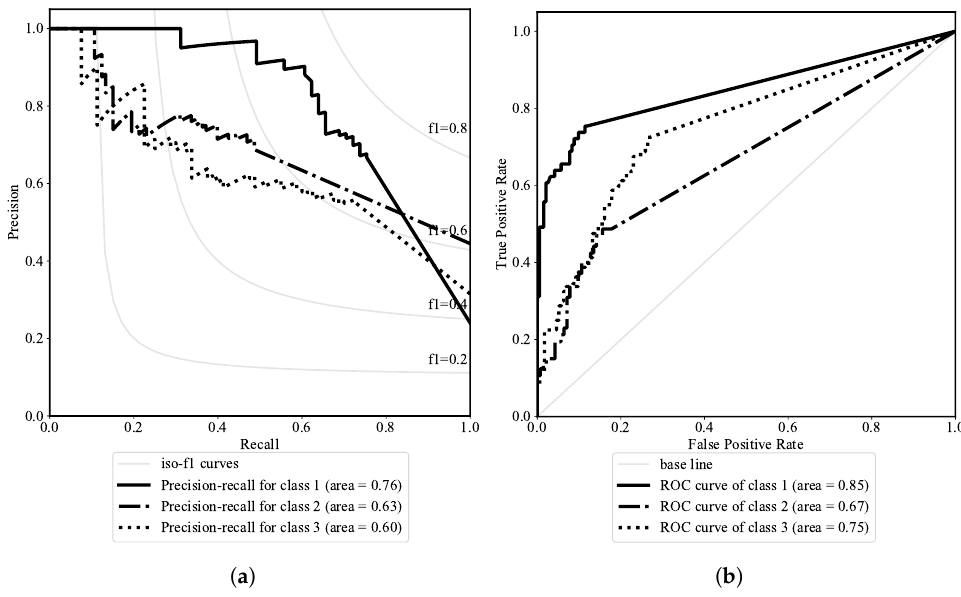
Figure 10. Performance of M DL ( FRC , RN ) in terms of: ( a ) Recall-Precision Curve; ( b ) ROC